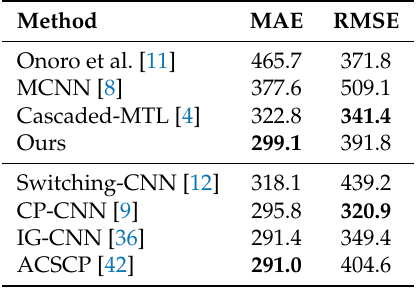
Figure 6. Density estimation results on the UCF_CC_50 [3]. ( a ) Input images, ( b ) ground truth density maps, and ( c ) estimation results. Table 5. Comparison of networks on the UCF_CC_50